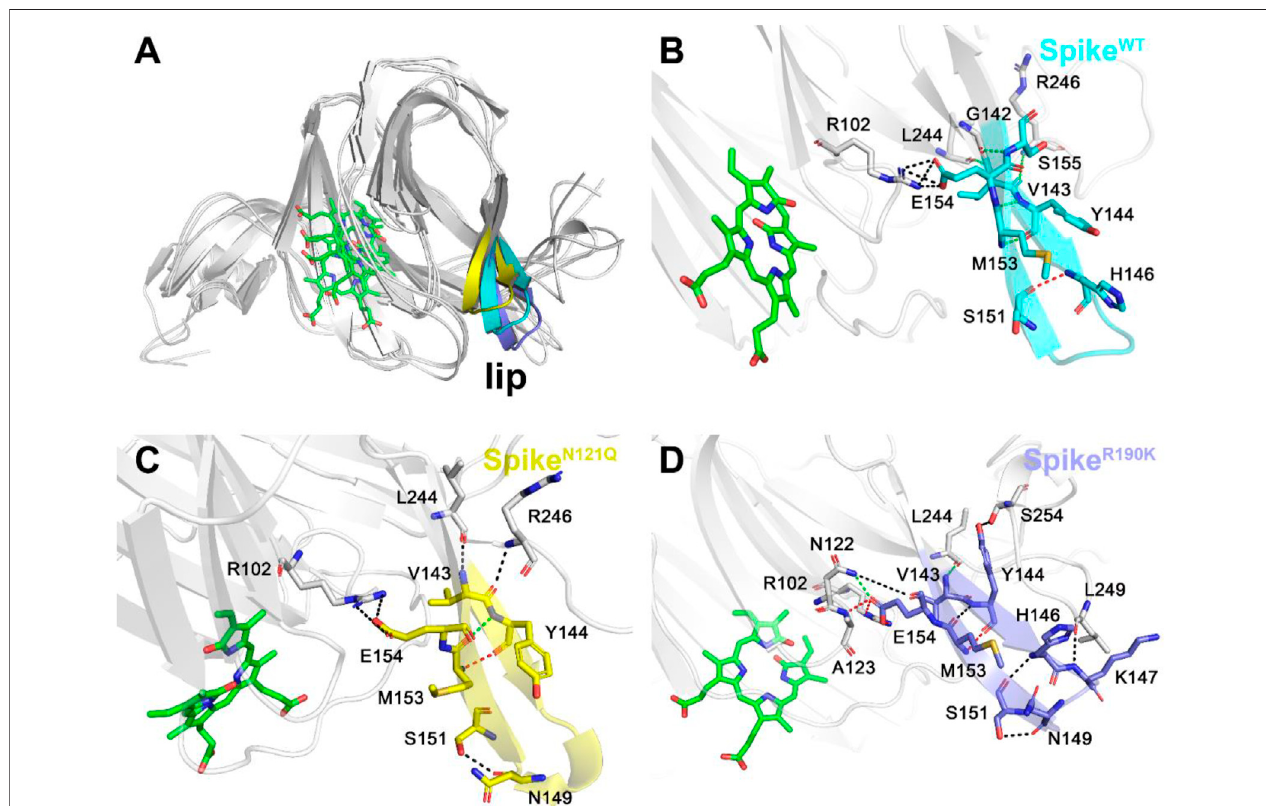
FIGURE 6 | Three different colors, red, green, and black, representing strong, moderate, and weak hydrogen bond interactions, were applied according to their probability range of > 80%, 60% – 80%, and 30% – 60%, respectively. (A) Comparison of the lip loops in three systems. (B) Illustration of the hydrogen bond interaction of the lip in Spike WT /Biliverdin, (C) in Spike N121Q /Biliverdin, and (D) in Spike R190K